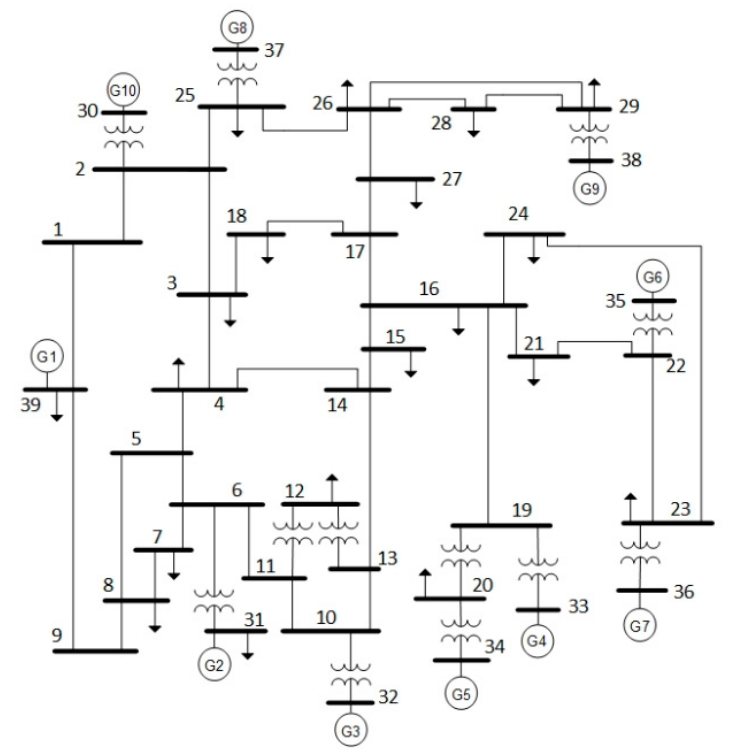
Figure 6. Single-line diagram of New England 39 bus test system [60].